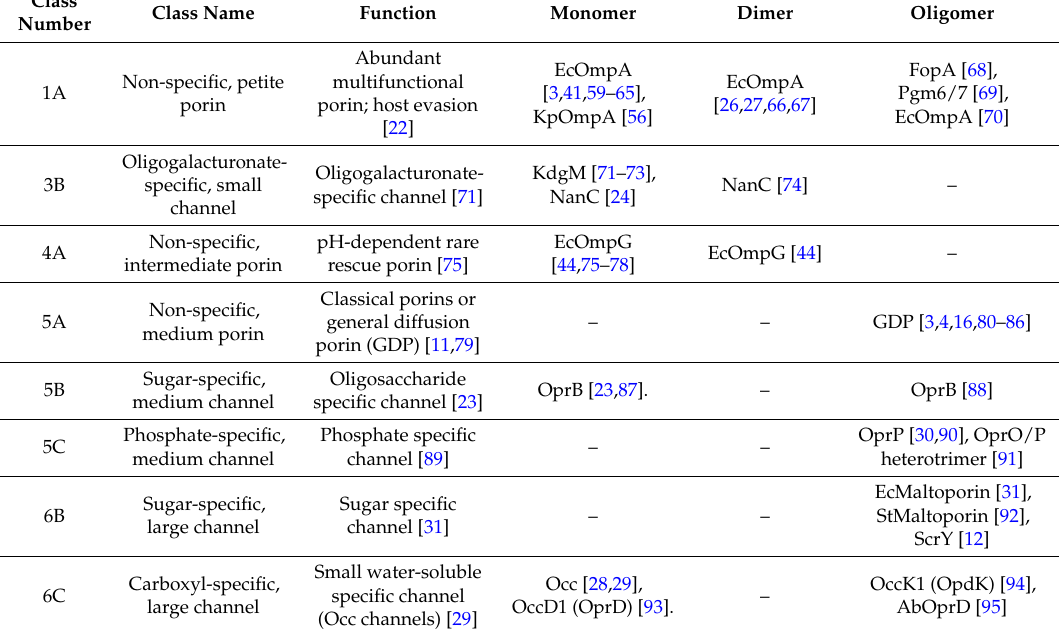
Table 6. Non-specific porin and specific diffusion channel oligomerization state. This table lists articles discussing the multimeric state of non-specific porins and specific diffusion channels, the protein name and information regarding the presumed multimeric state (monomeric, dimeric or